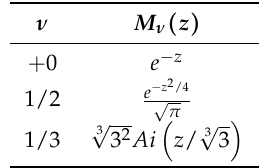
Table A1. Special cases of the M-Wright